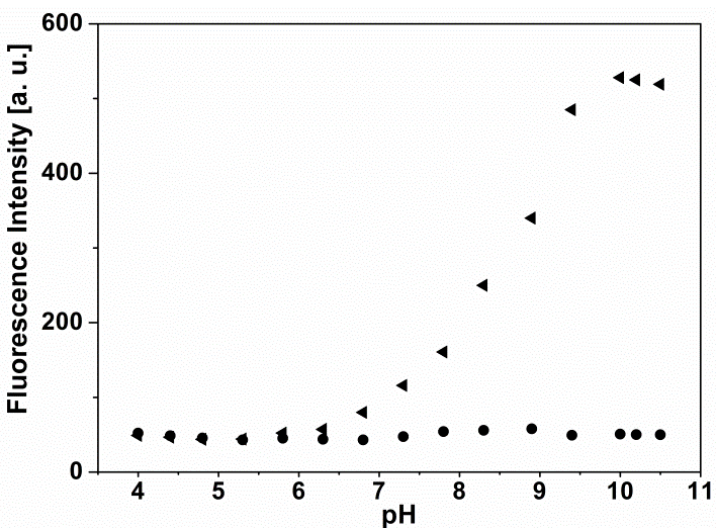
Figure 1. pH effect on the fluorescence spectra of P (10 μM) (●) and P (10 µM) plus Mg 2+ (100 µM) ( ◄ ) in water – ethanol solution (1:9, v : v , 20 mM HEPES). The pH was adjusted by adding 1.0 M NaOH or 1.0 M HCl in HEPES buffers.